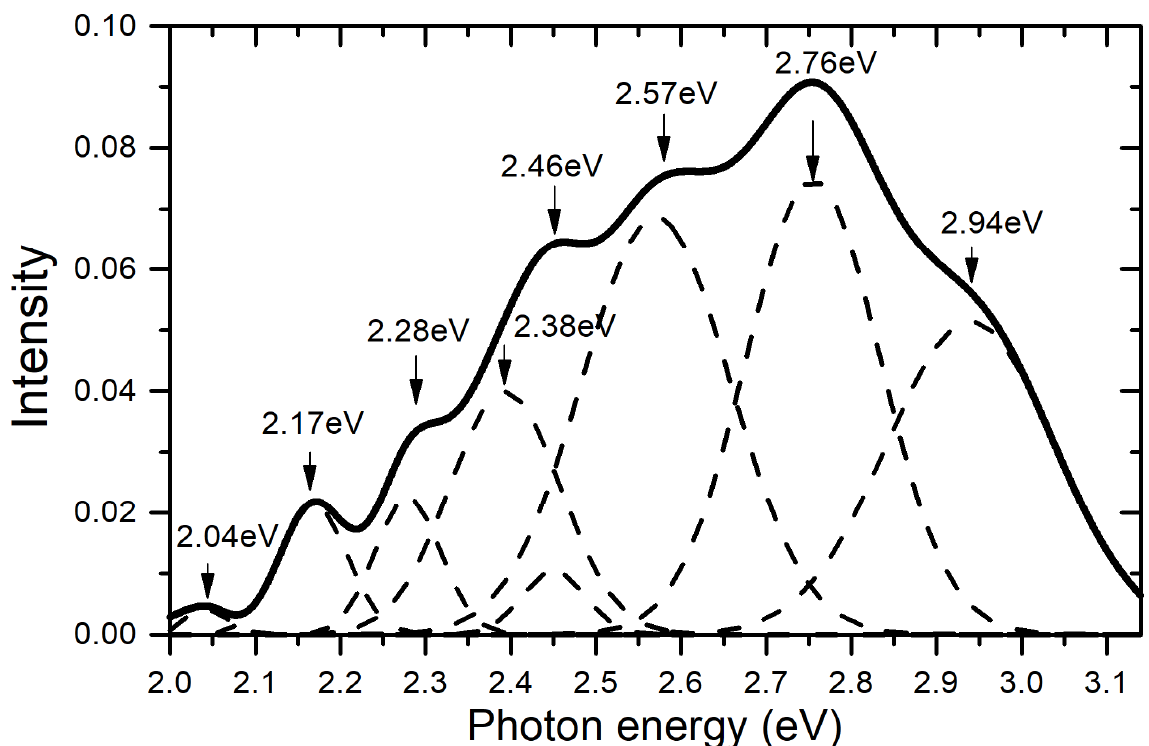
Figure 5. Differential PL spectra of ZnSeO 3 /SiO 2 /Si after CD for 15 min, with Gaussian curves.